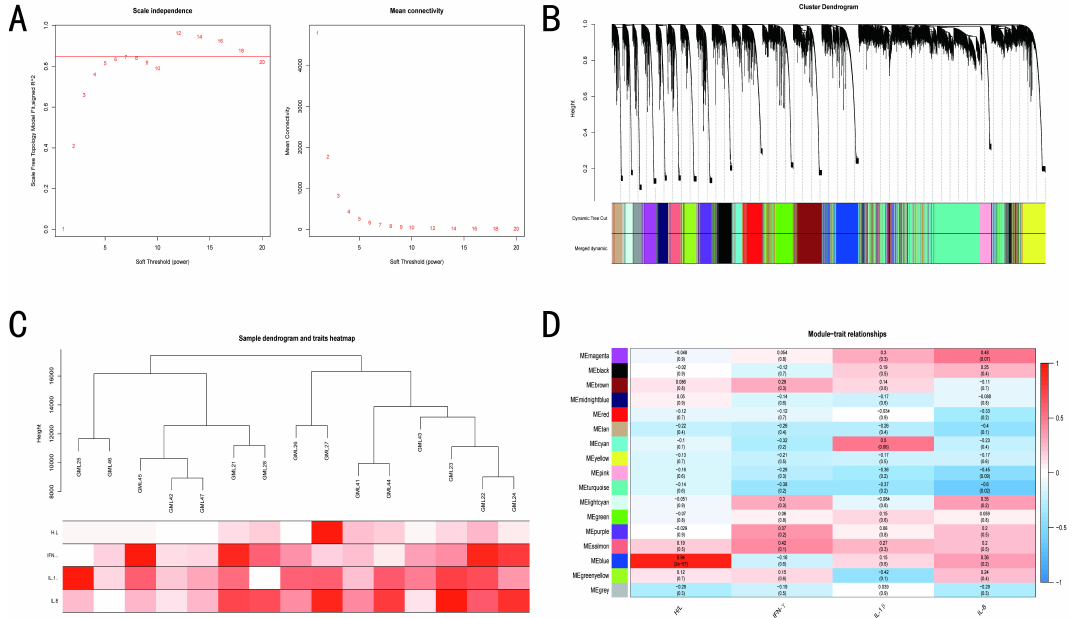
Figure 5. WGCNA results of GM show the modules significantly correlated with treatment (ST infection) and blood indicators (H/L ratio, IL-1 β , IL-8 and IFN- γ ). ( A ) Analysis of network topology for various soft-thresholding powers. ( B ) Clustering dendrogram of genes, with dissimilarity based on topological overlap, together with assigned module colors. ( C ) Eigengene dendrogram and eigengene adjacency plot. ( D ) Module-trait associations. Each row corresponds to a module, and each column corresponds to a trait. Each cell contains the corresponding correlation and p